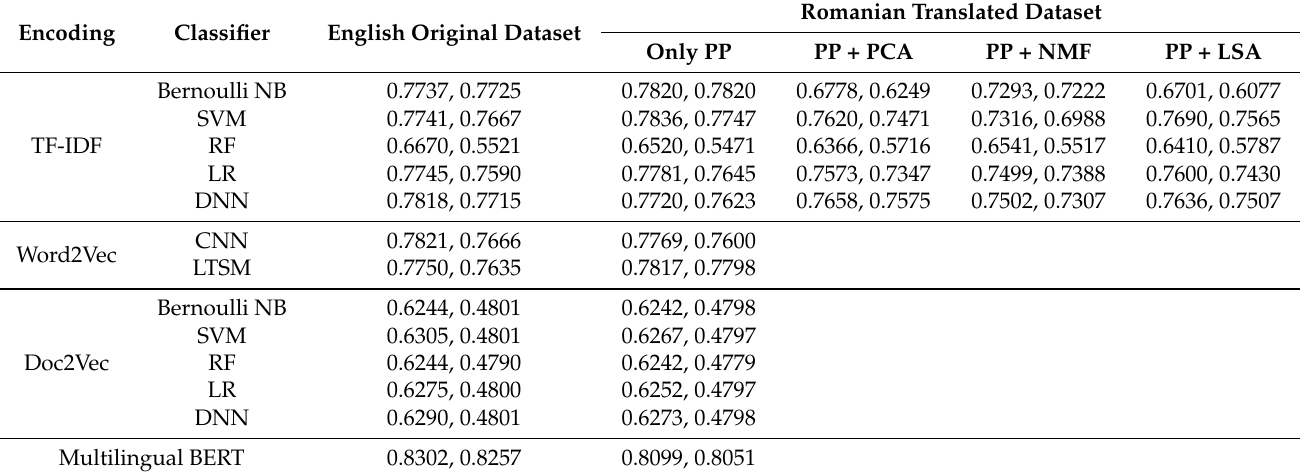
Table 1. Classifier performance (accuracy and weighted F1-measure) with or without dimensional- ity reduction.